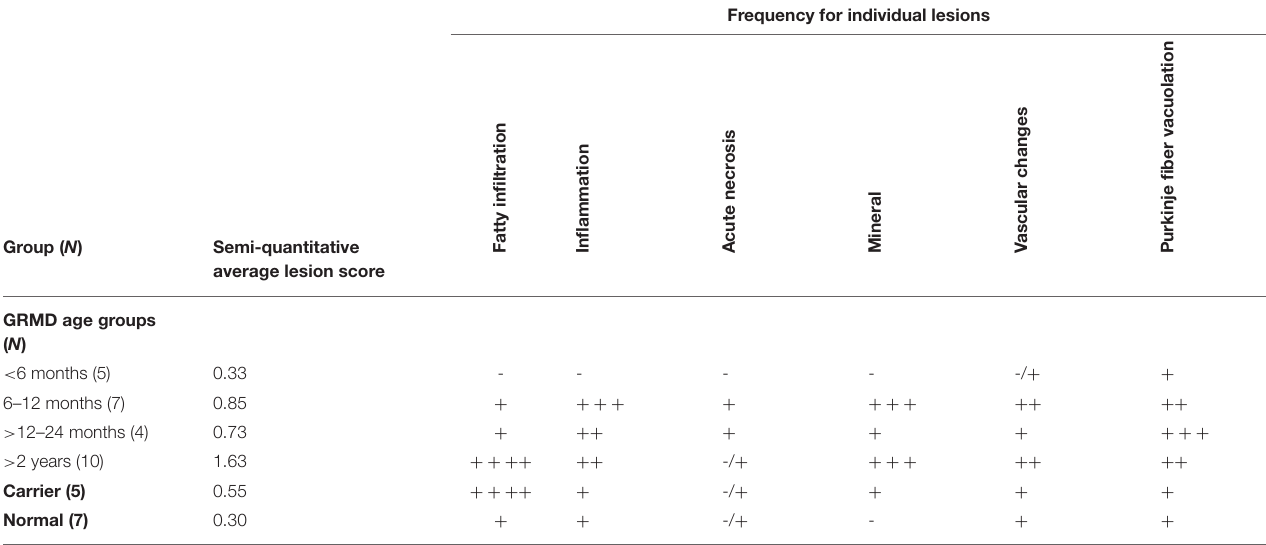
TABLE 2 | Averages of histologic changes for